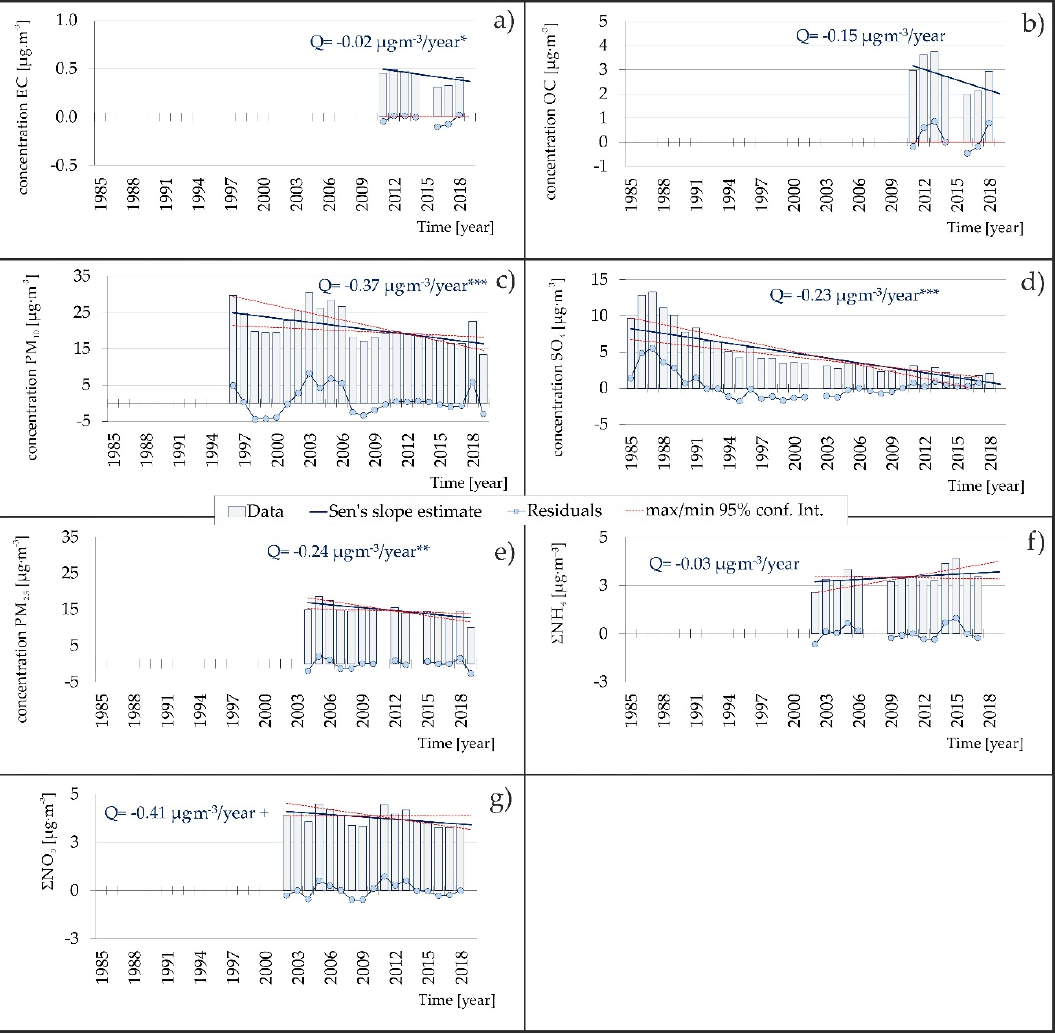
Figure 5. Results of Mann–Kendal test for aerosol particles; ( a ) EC, ( b ) OC, ( c ) PM 10 , ( d ) SO 4 , ( e ) PM 2,5 , ( f ) ∑ NH 4 , ( g ) ∑ NO 3.